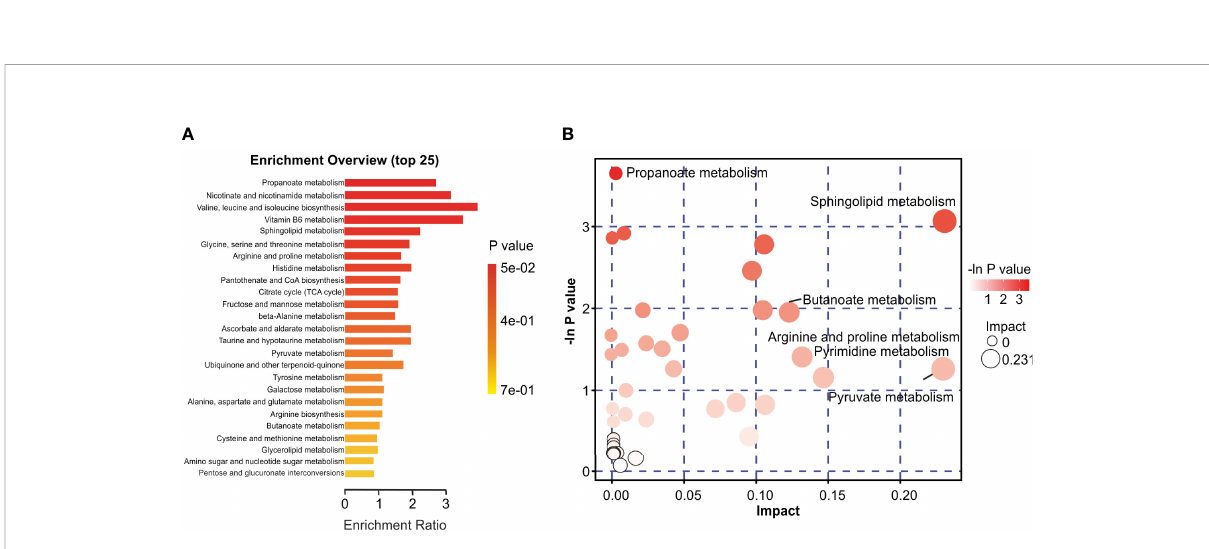
FIGURE 6 Characteristics of the oropharyngeal metabolome in IAV pneumonia and healthy volunteer groups. (A) Differential Pathway enrichment analysis based on differential metabolites between the two groups. (B) The crucial pathway with the highest correlation with metabolite differences between groups F and H was identi fi ed following metabolic pathway analysis of differential metabolites. In the bubble chart, each bubble represents a metabolic pathway. The X-axis and bubble size indicate the size of the impact value of the pathway; the Y-axis and bubble color indicate the p-value (-ln p ) of the enrichment analysis. F, IAV pneumonia group; H, healthy group; IAV, in fl uenza A